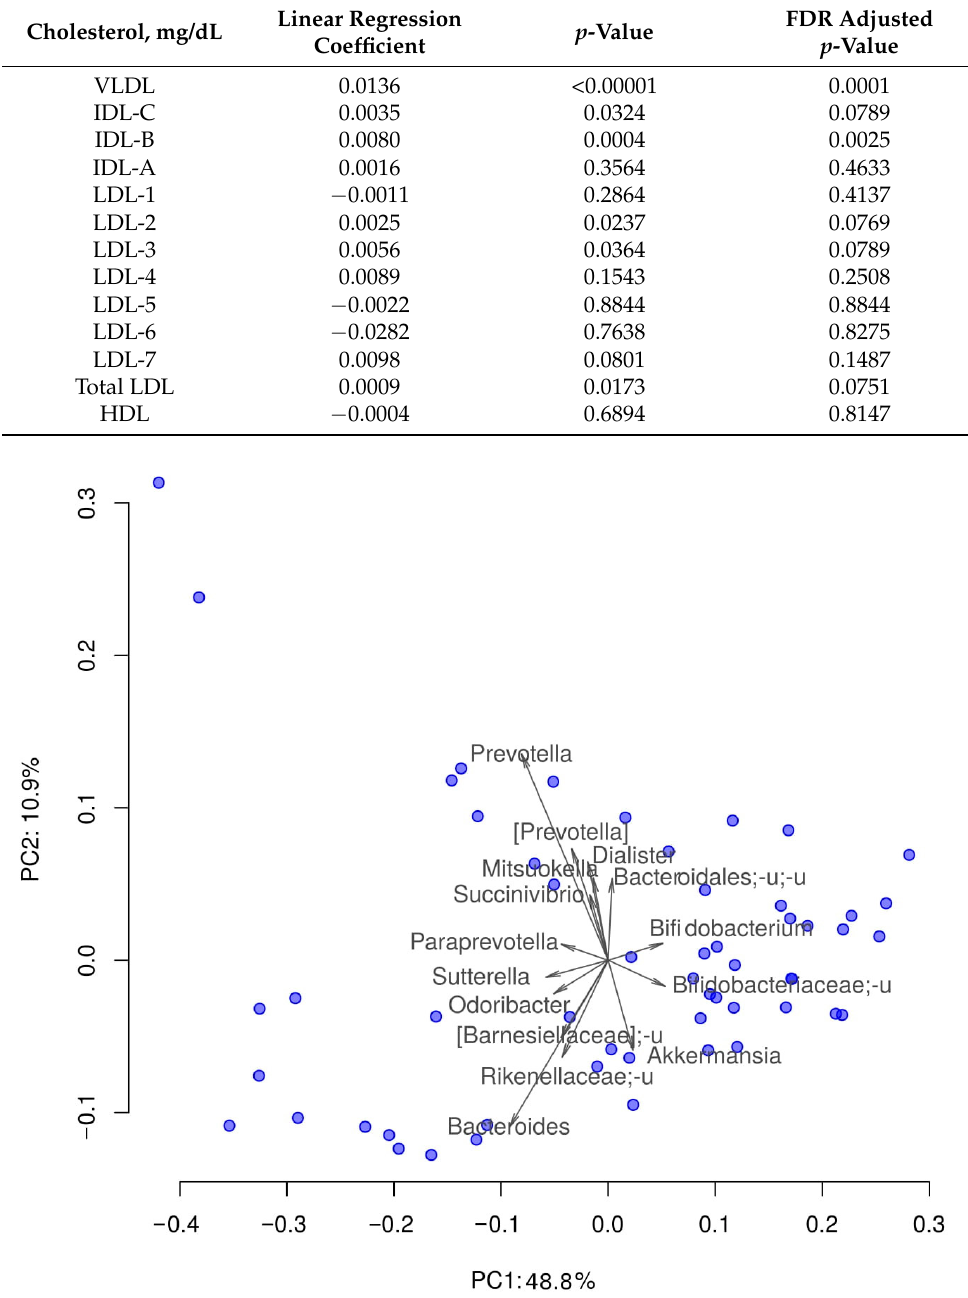
Table 3. Cholesterol content in lipoprotein subfractions and intima-media thickness (N = 287).